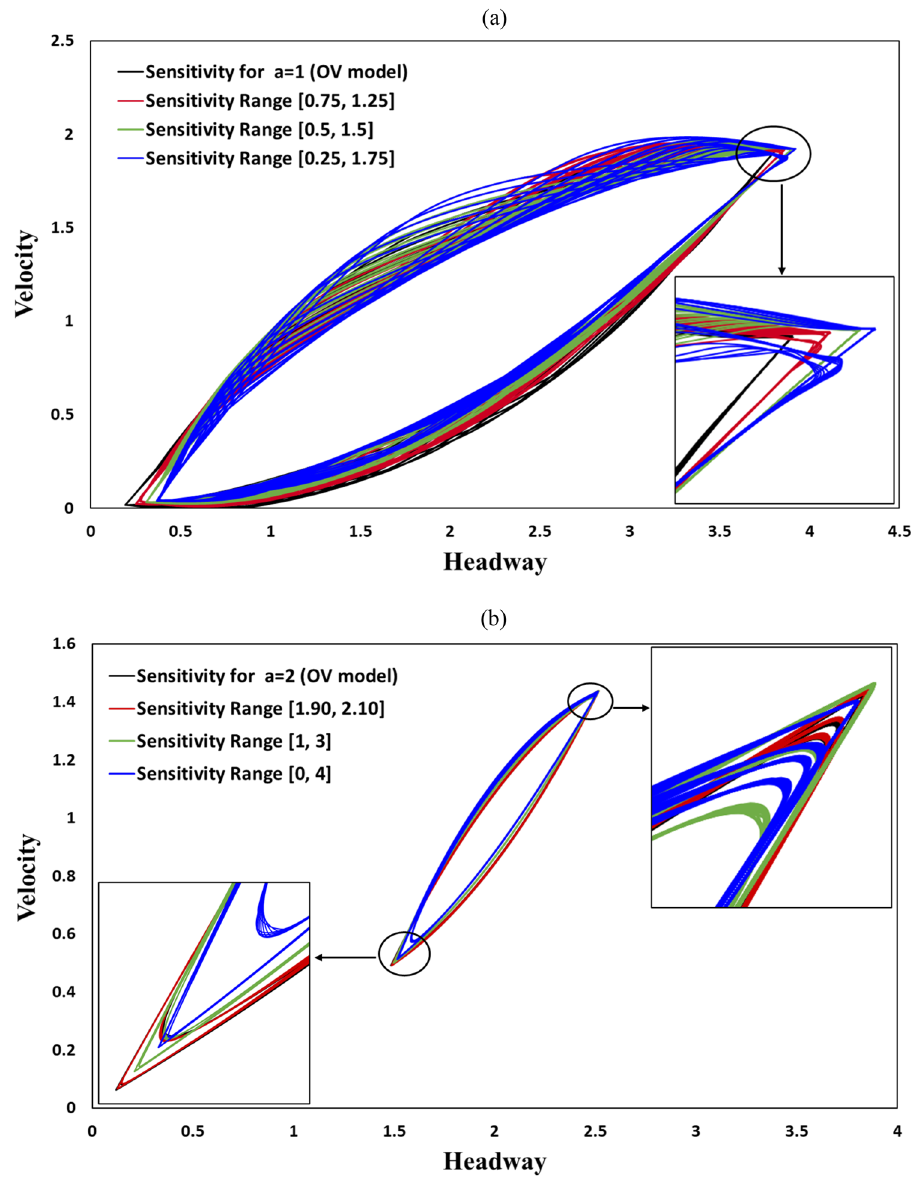
Figure 5. Hysteresis loops comparison analysis for the conventional OV for ( a ) a = 1 , and ( b ) a = 2 and the HDDS models with several sensitivity ranges, while keeping the average of maximal and minimal sensitivities + a min = 1 , and ( b ) a = 2 . The insets show the detail of both the top = a max + a min constant at ( a ) a avg = a max avg 2 2 and bottom